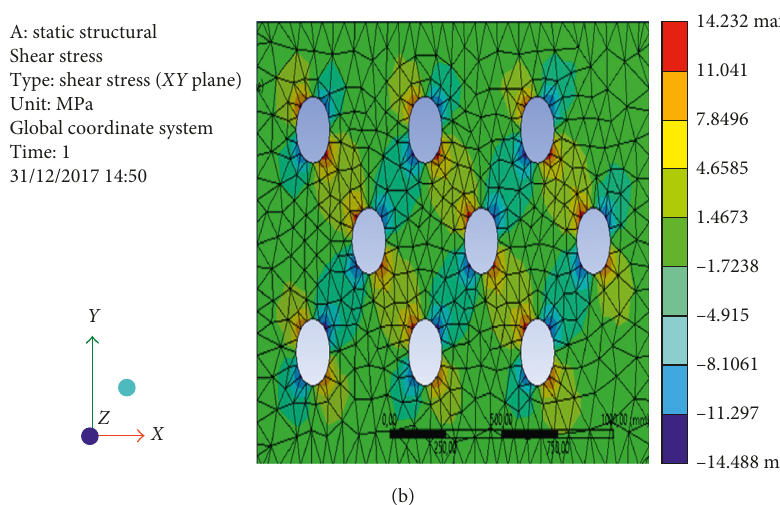
Figure 17: Redistribution and magnitude of stresses around 9 holes drilled in staggered mesh. (a) Normal stress. (b) Shear stress.